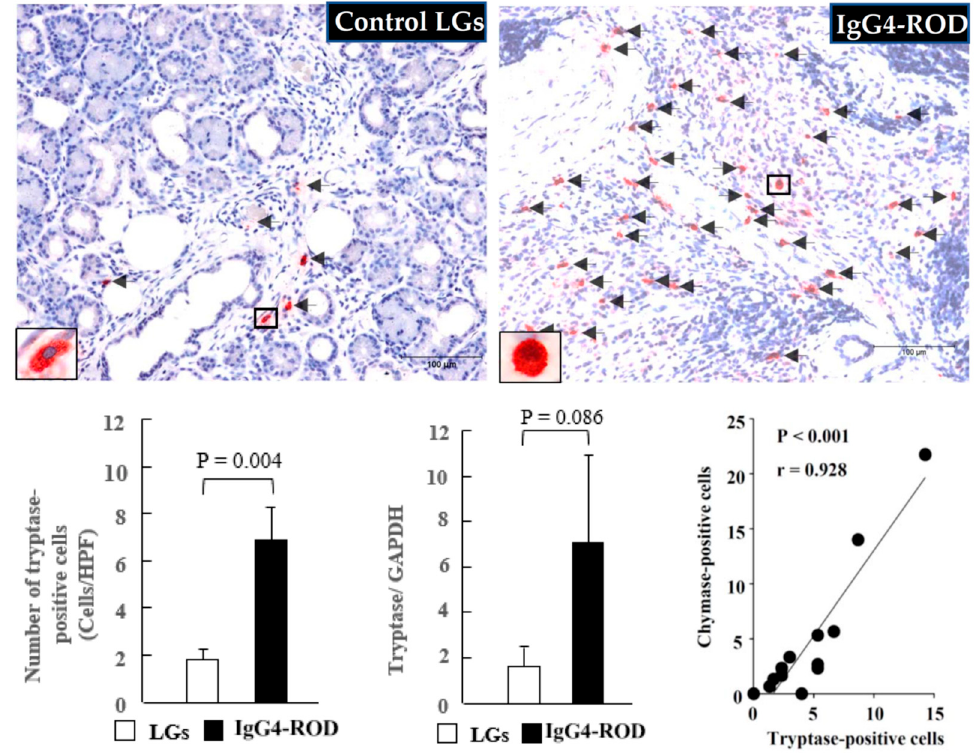
Figure 4. Representative images of tryptase immunostaining, the tryptase-positive cell population, and the tryptase expression of the LGs obtained from the patients with IgG4-ROD and from the control patients diagnosed with severe canalicular obstruction yet with no IgG4-ROD. Bar graphs show the quantitation of the tryptase-positive cell numbers and the tryptase expression between the two groups. Line graph shows the linear regression analysis between the numbers of tryptase-positive cells and chymase-positive cells in all data of the examined LGs. Black arrows indicate the tryptase-positive cells.